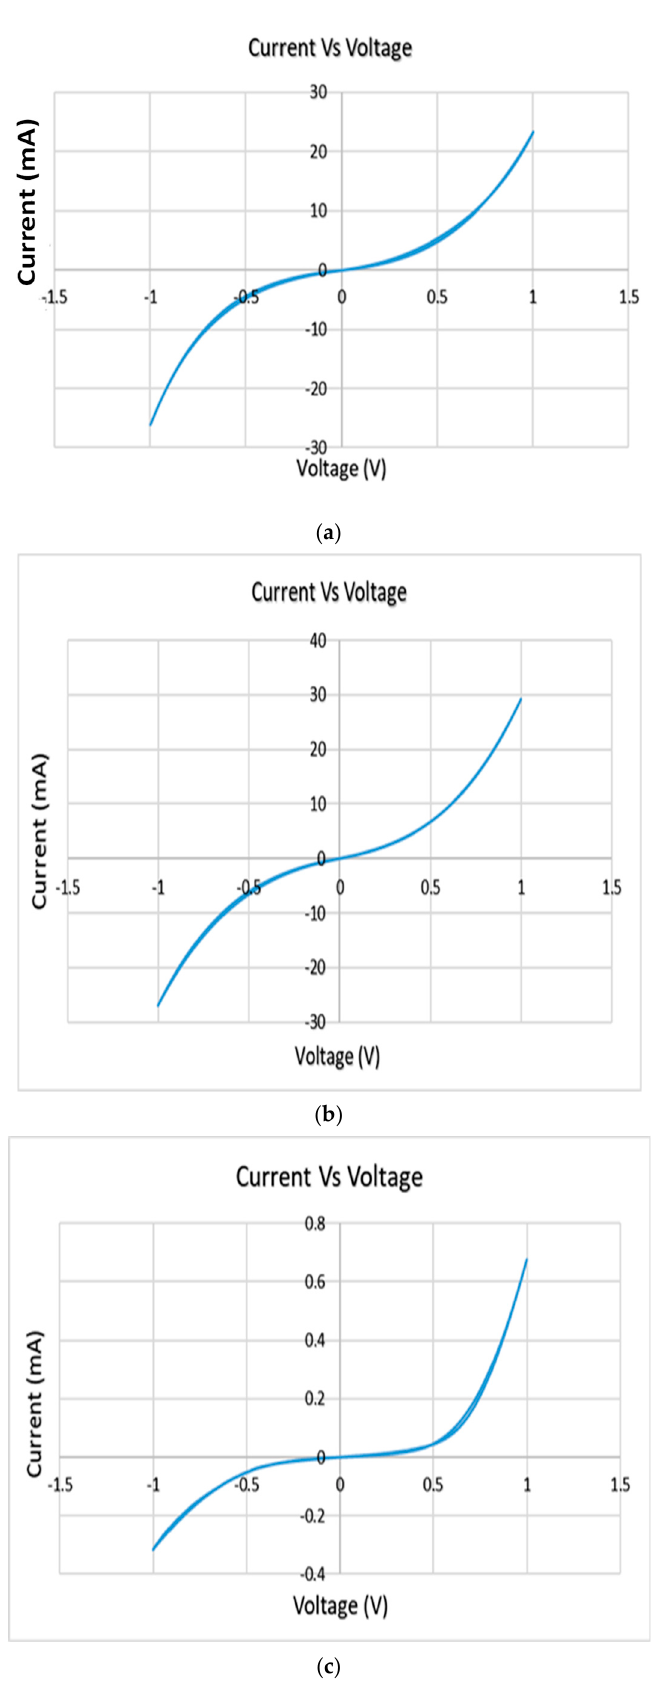
Figure 6. Cyclic voltammetry for samples 4 ( a ), 5 ( b ), and 6 ( c ). Compositions are shown in Table 4.